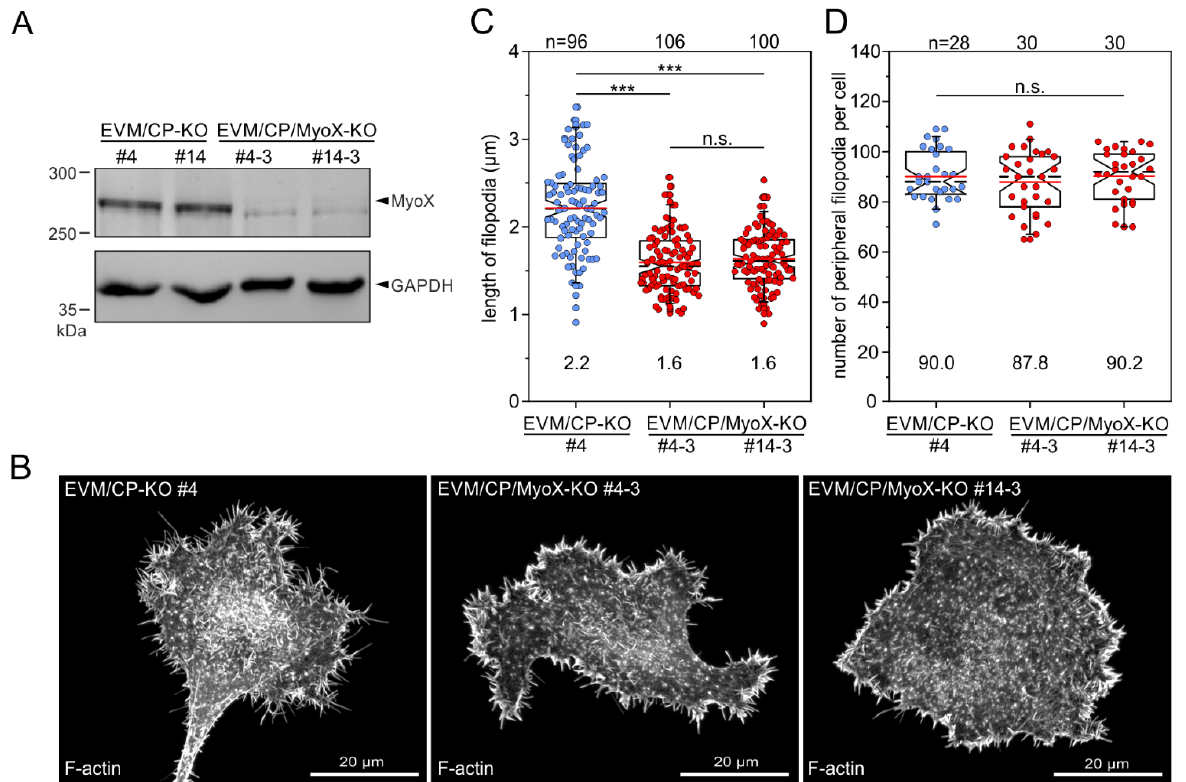
Figure 8. Loss of MyoX in EVM/CP-KO cells leads to additional reduction in filopodia length. ( A ) Immunoblot confirming elimination of MyoX in two independent EVM/CP/MyoX-KO mutants (clones #4-3 and #14-3). Loading control: GAPDH. ( B ) Morphologies of representative EVM/CP-KO and EVM/CP/MyoX-KO cells migrating on laminin and stained for the F-actin cytoskeleton with phalloidin. ( C ) Comparison of filopodium length in EVM/CP-KO versus EVM/CP/MyoX-KO cells. Note the significantly shorter filopodia in EVM/CP/MyoX-KO mutants. ( D ) Quantification of the number of peripheral filopodia in EVM/CP-KO and EVM/CP/MyoX-KO cells. ( C , D ) The boxes in box plots indicate 50% (25–75%) and whiskers (5–95%) of all measurements, with dashed black lines depicting the medians and arithmetic means highlighted in red. ( C ) Non-parametric Kruskal–Wallis test and Dunn’s Multiple Comparison test and ( D ) one-way ANOVA and Tukey Multiple Comparison test were used to reveal statistically significant differences between datasets. *** p ≤ 0.001; n.s.: not significant. n: number of peripheral filopodia ( C ) or cells ( D ) analyzed from three independent